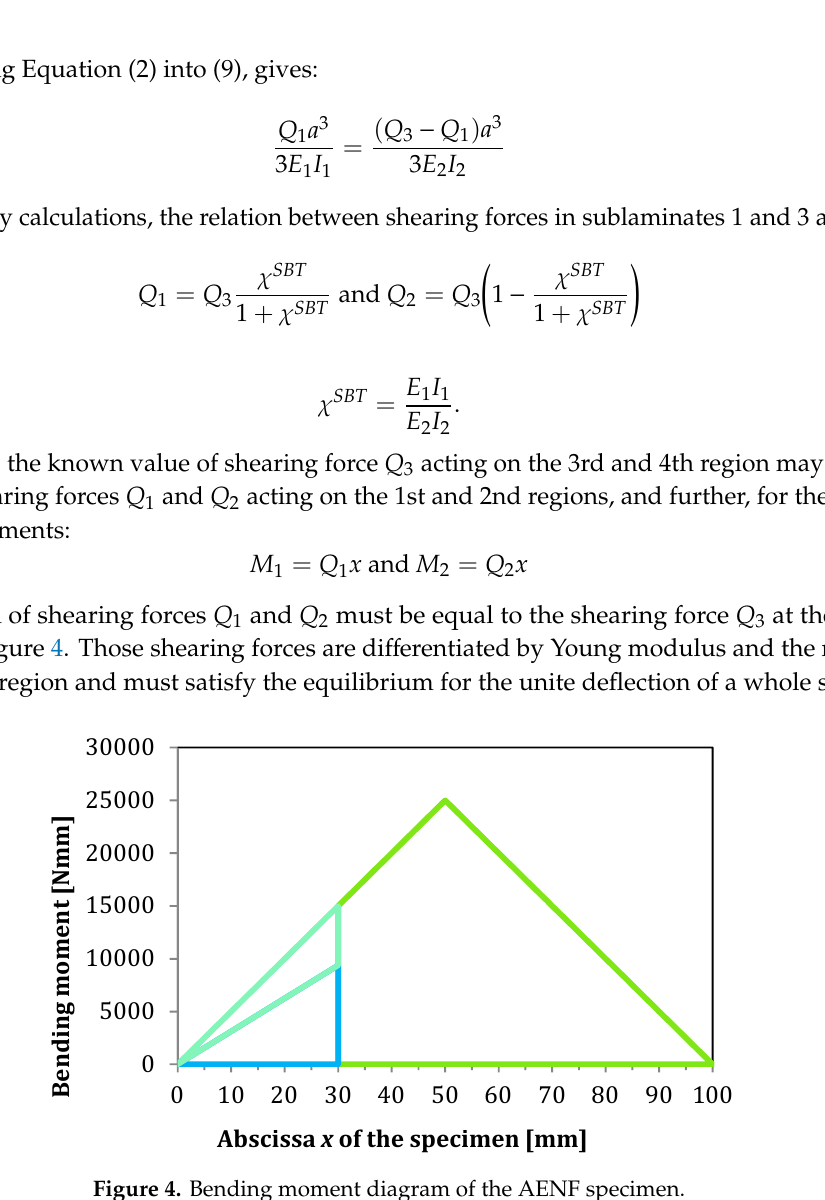
Figure 4. Bending moment diagram of the AENF specimen.